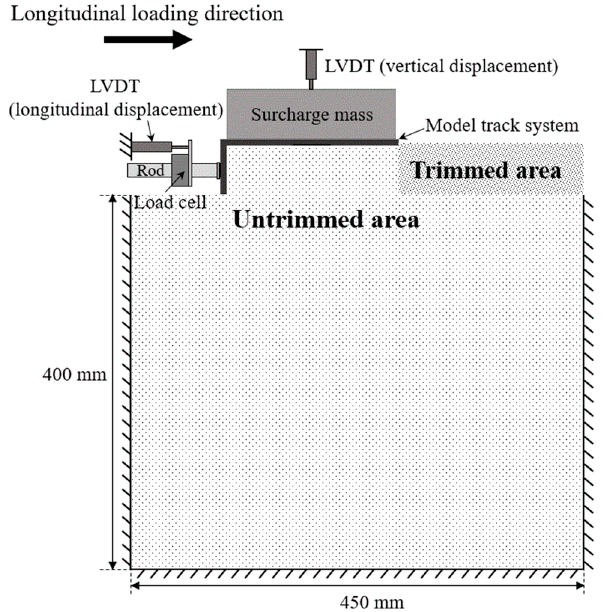
Figure 6. Schematic drawing of the model experiments (cross-section view).